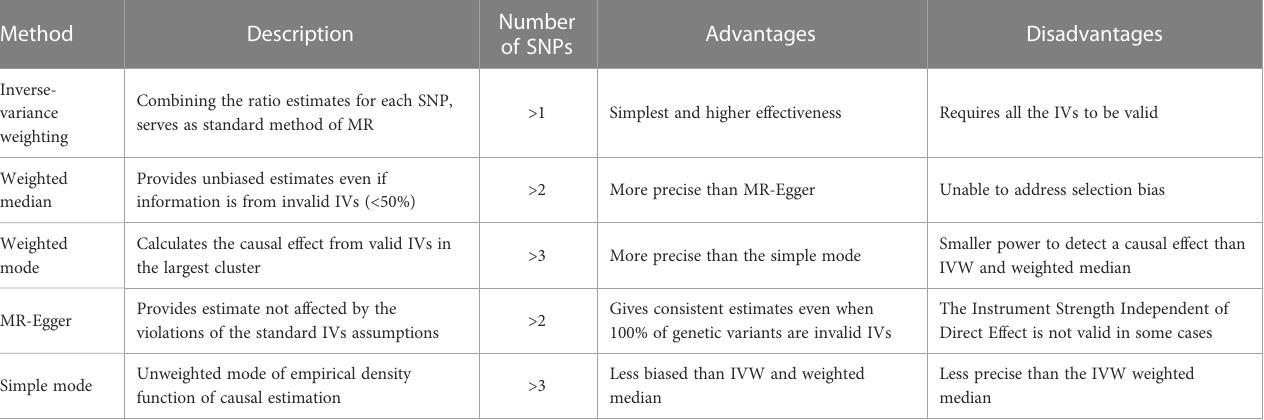
TABLE 1 Characteristics of fi ve Mendelian randomization (MR)